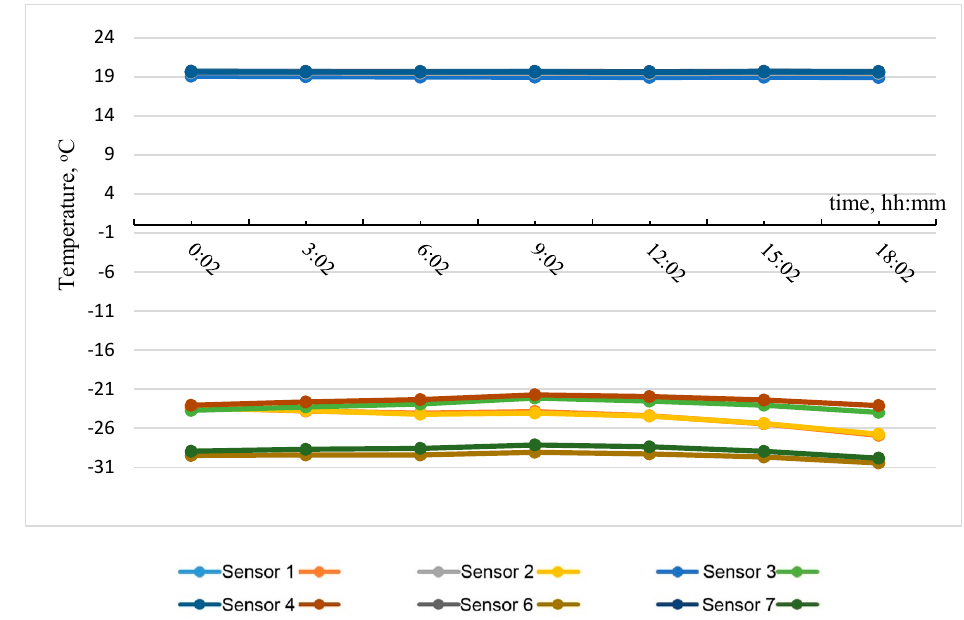
Figure 10. Temperature on the specimen No. 2 surface with time.